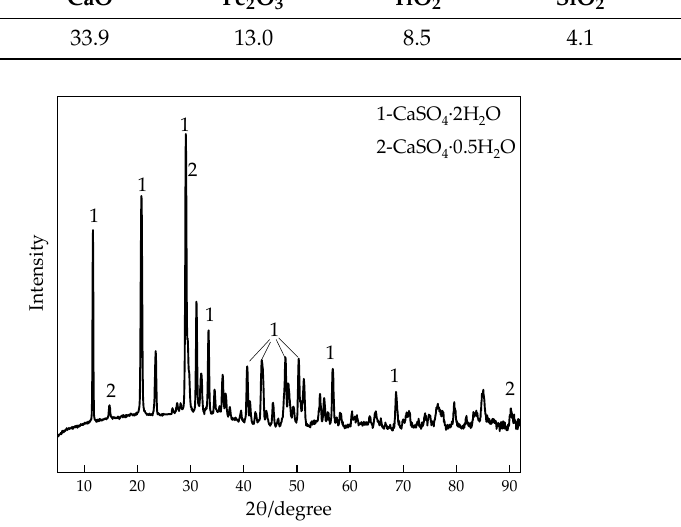
Figure 3. XRD pattern of titanium gypsum.